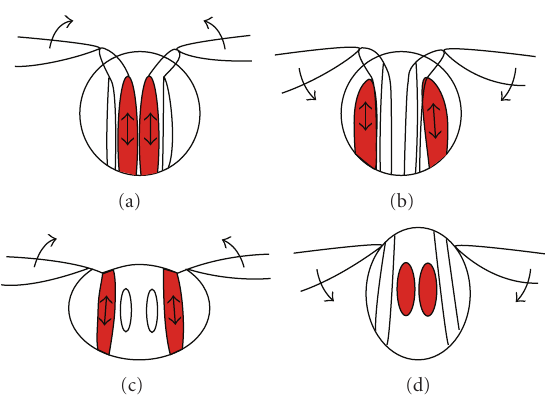
Figure 12: Insect wings beat generation: direct muscles (a, b) and indirect muscles (c, d) [35].